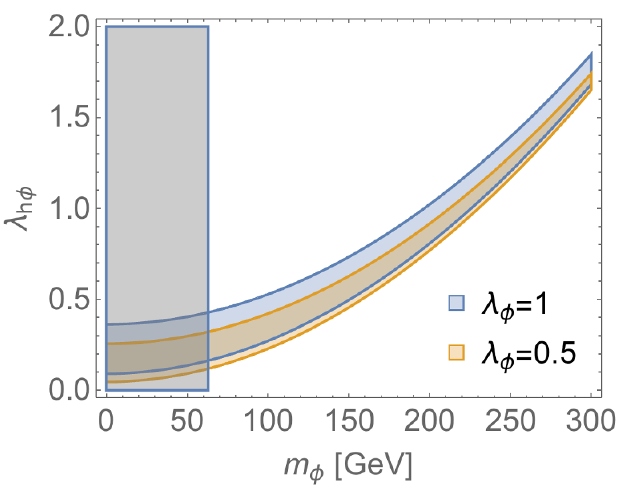
Figure 1 . Two-step EWPT select conditions allowed parameter spaces. The gray region is excluded by the Higgs invisible decay